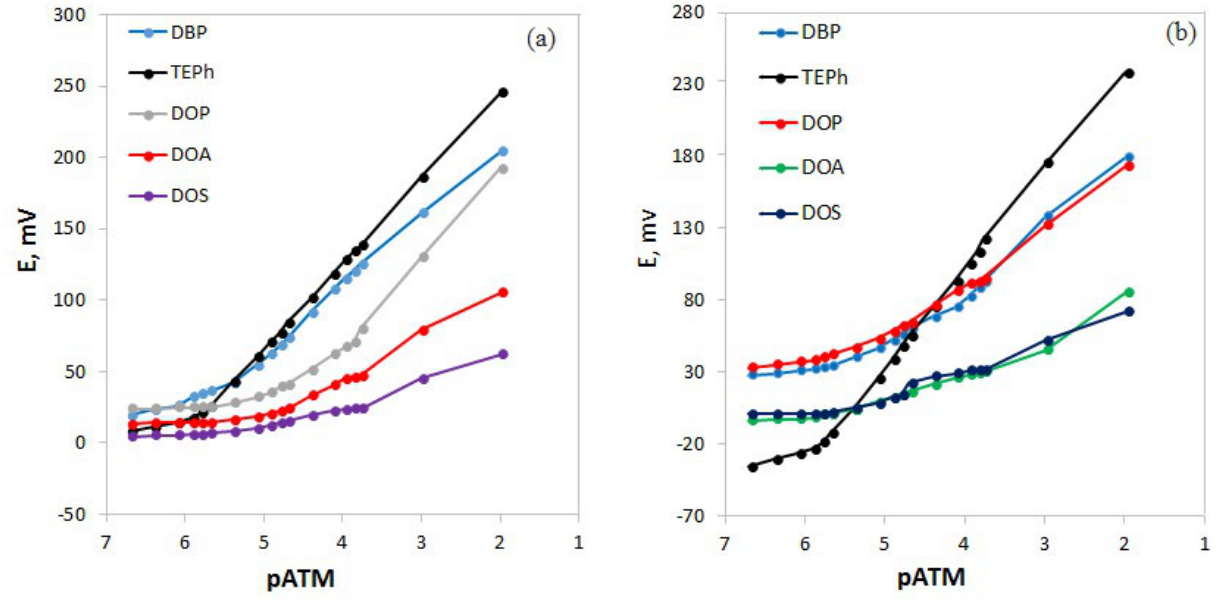
Fig 2. Effect of different plasticizers on the response of (a) ATM-TPB and (b) ATM-PTA